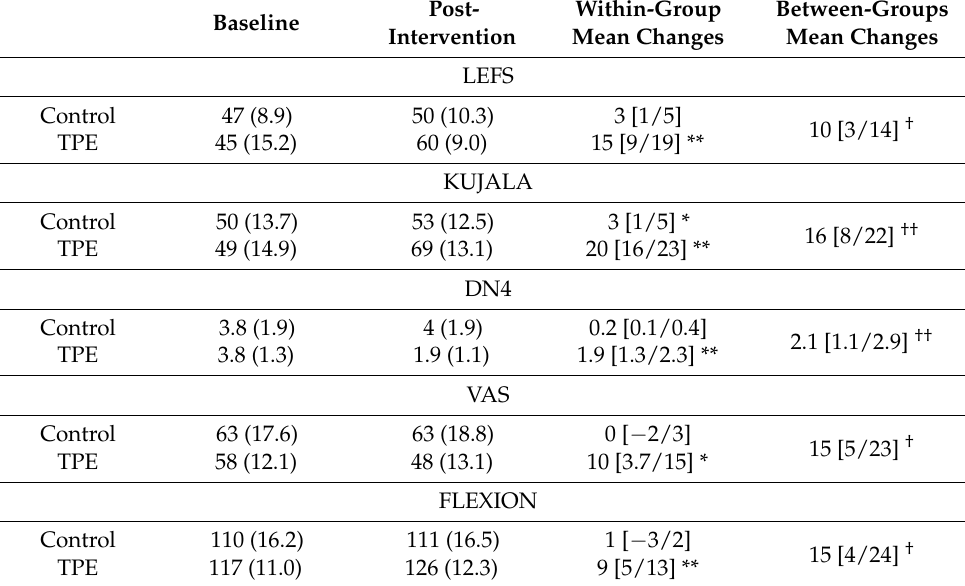
Table 3. Baseline, post-intervention, and mean score changes of knee pain and lower extremity function. Post- Within-Group Baseline Intervention Mean Changes